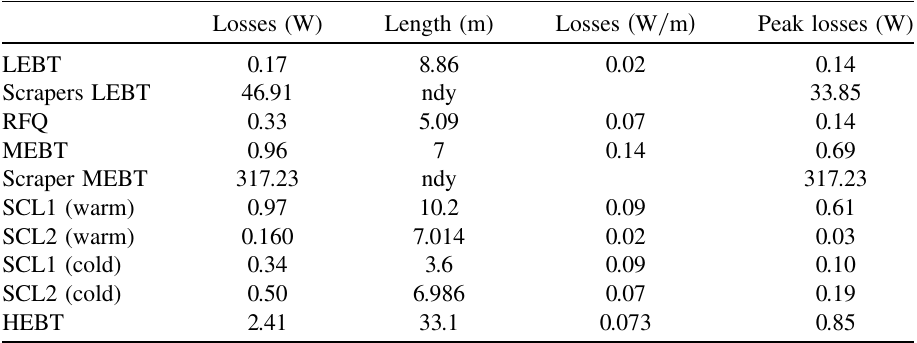
TABLE VII. Average losses repartition according to linac section (ndy means ‘‘not designed yet’’).